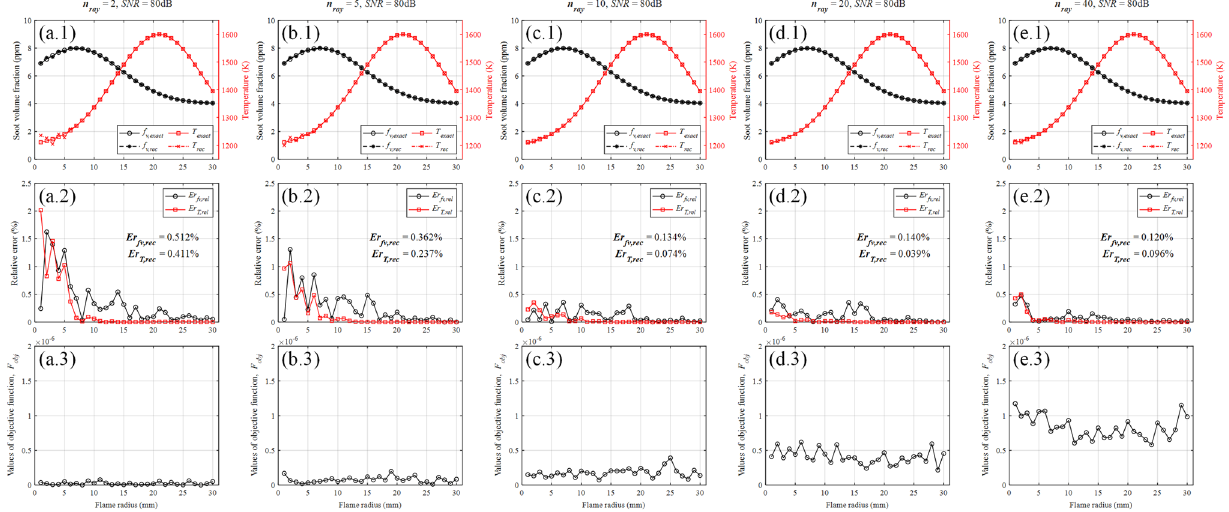
Figure 6. The reconstructed results with different n ray on the condition of SNR = 80 dB. ( a ) n ray = 2. ( b ) n ray = 5. ( c ) n ray = 10. ( d ) n ray = 20. ( e ) n ray = 40.